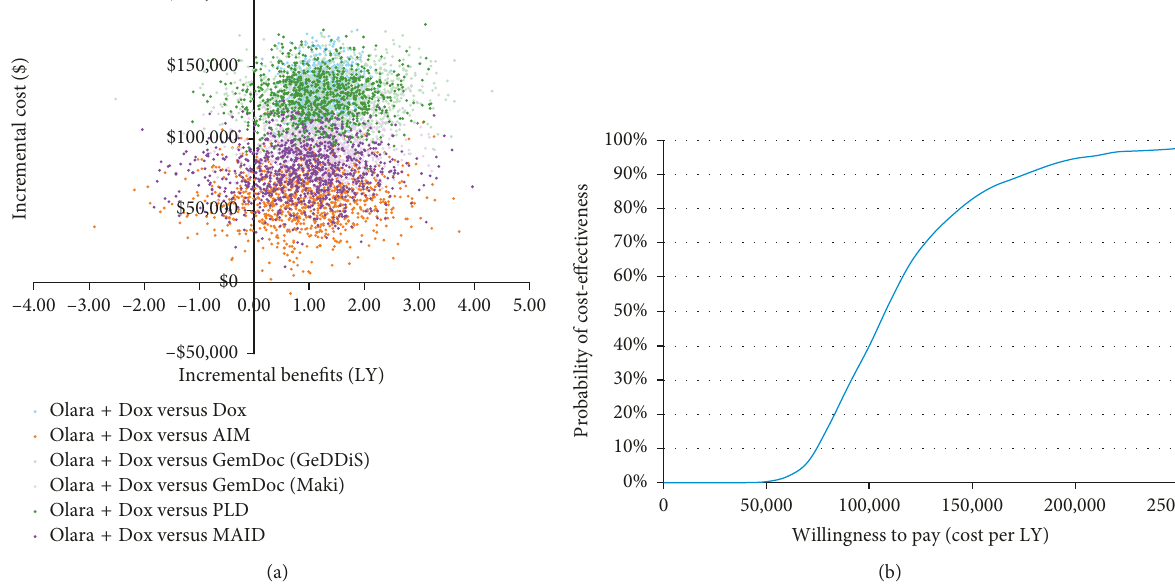
Figure 4: Probabilistic sensitivity analysis results. (a) Cost-effectiveness plane (base case); (b) cost-effectiveness acceptability curve (Olara +Dox versus Dox). (a) shows the joint distribution of incremental costs and LYs estimated by 1,000 model simulations for each treatment comparison in which the mean values for all model parameters were sampled simultaneously from their individual statistical distributions. Details of the distributions are presented in Supplementary Materials. (b) shows the probability of cost-effectiveness for Olara+Dox versus Dox as a function of the ICER threshold (the additional cost per LY gained that the decision-maker is willing to pay). From this and equivalent analyses for each pairwise treatment comparison, the probability that Olara+Dox is cost-effective at a willingness-to-pay threshold of $150,000 per LY gained was estimated as 83% versus Dox, 93% versus AIM, 93% versus GemDoc (GeDDiS), 94% versus GemDoc (Maki), 87% versus PLD, and 90% versus MAID. AIM ifosfamide+doxorubicin+mesna; Dox doxorubicin; GemDoc gemcitabine+docetaxel; (cid:31) (cid:31) (cid:31)